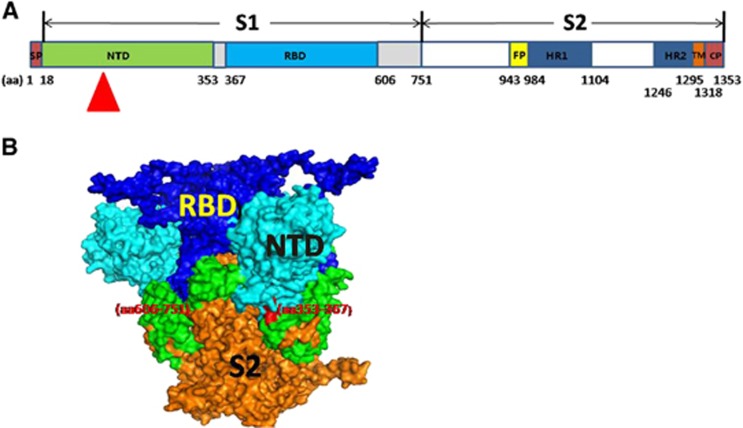
Schematic diagram and analogous three-dimensional (3D) structure of the MERS-CoV S protein. (A) Amino acid sequences of the recombinant proteins (rNTD, rRBD, rS1, rS2 and rS) evaluated in this study. The NTD region of focus in this study is indicated by a red triangle. (B) The 3D structure of the MERS-CoV S protein was predicted using PyMOL, and the side view or transverse view is shown based on the trimeric S structure of HKU1.18 N-terminal domain (NTD), RBD, S2 and the 367–606 and 606–751 aa regions are colored in light blue, dark blue, orange, red and green, respectively.